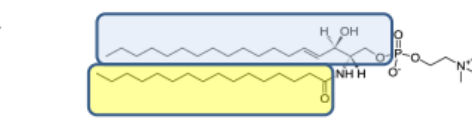
Figure 1. Different molecules of sphingomyelin according to the length and unsaturation of the acyl residue and sphingoid. A, fatty acid compositions of sphingomyelin species (yellow box) and A and B, long-chain base compositions of sphingomyelins (blue box). Note that the major difference among SM molecules is length and saturation of fatty